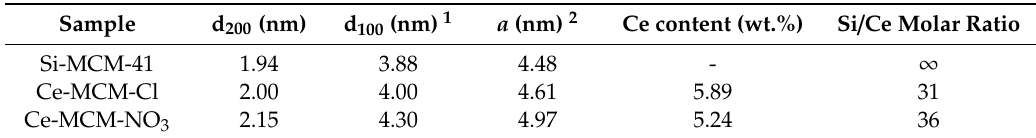
Table 1. XRD and XRF data of calcined MCM-41